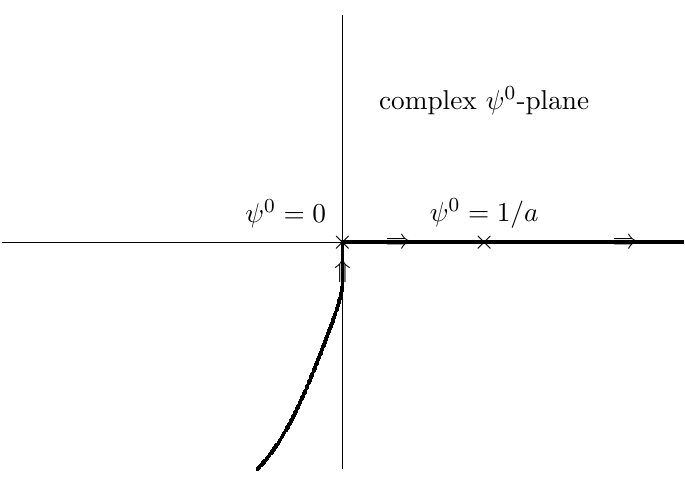
Figure 1 . The integration contour in the complex ψ 0